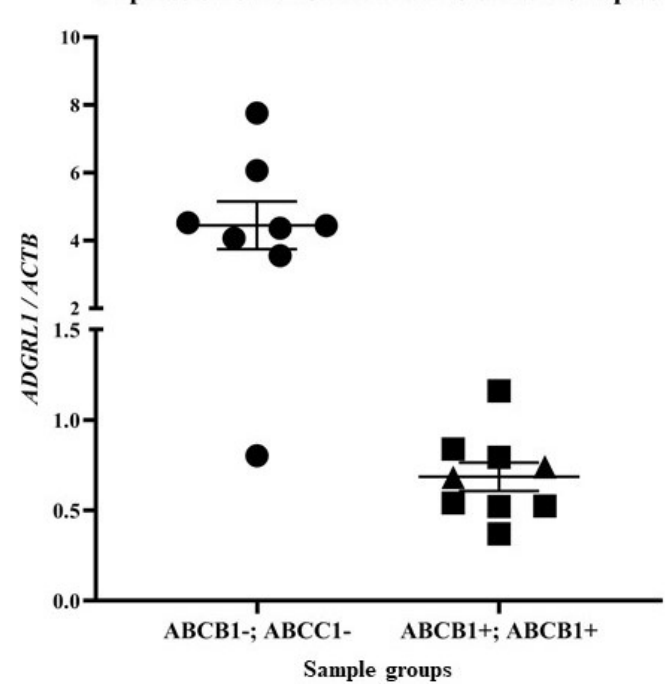
Figure 1. Detection of ADGRL1 mRNA expression by RT-PCR in samples from patients with MDS with and without expression of the ABC transporters ( ABCB1 and ABCC1 ) involved in multidrug resistance. Data represent the mean ± SEM for each statistical sample group. Data for ABCB1+/ABCC1+ cases differ significantly from the ABCB1 − /ABCC1 − at the level p ≤ 0.001. ABCB1 − /ABCC1 − cases are depicted by circles, ABCB1+/ABCC1+ cases by squares, while samples with only ABCC1+ are depicted by triangles.